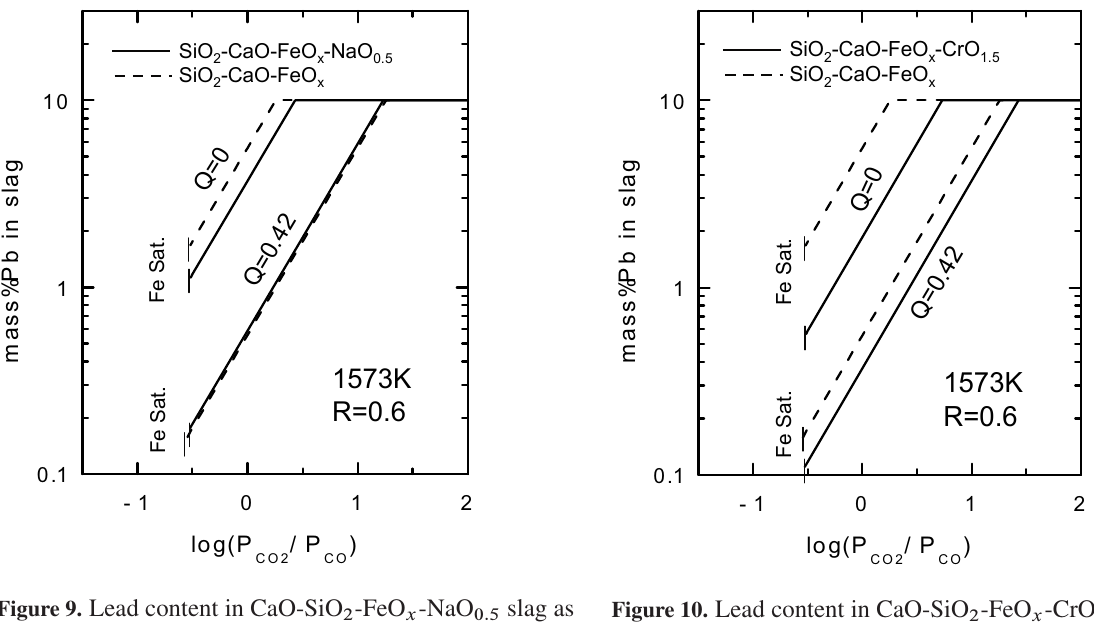
Figure 10. Lead content in CaO-SiO 2 -FeO x -CrO 1:5 slag as =P CO / at 1573 a function of log ( P CO 2